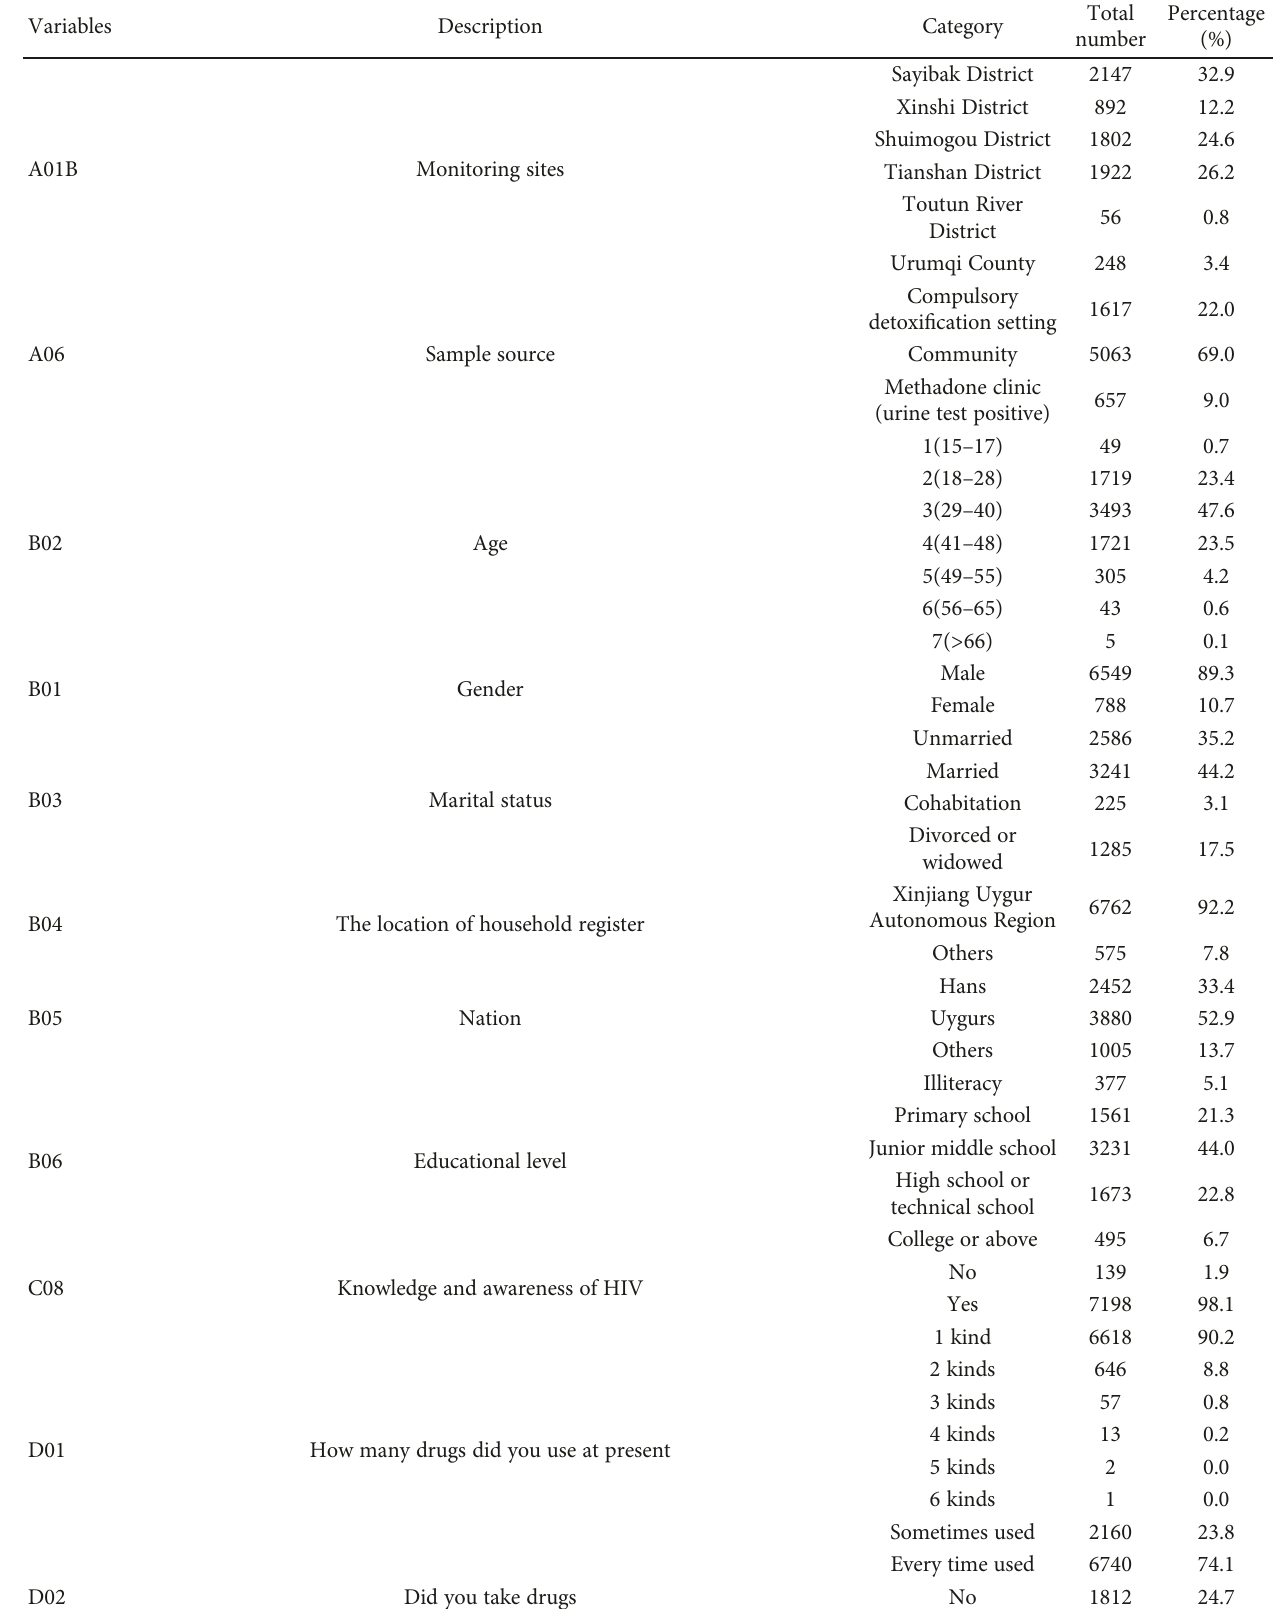
Table 3: Details of the attributes of the IDU